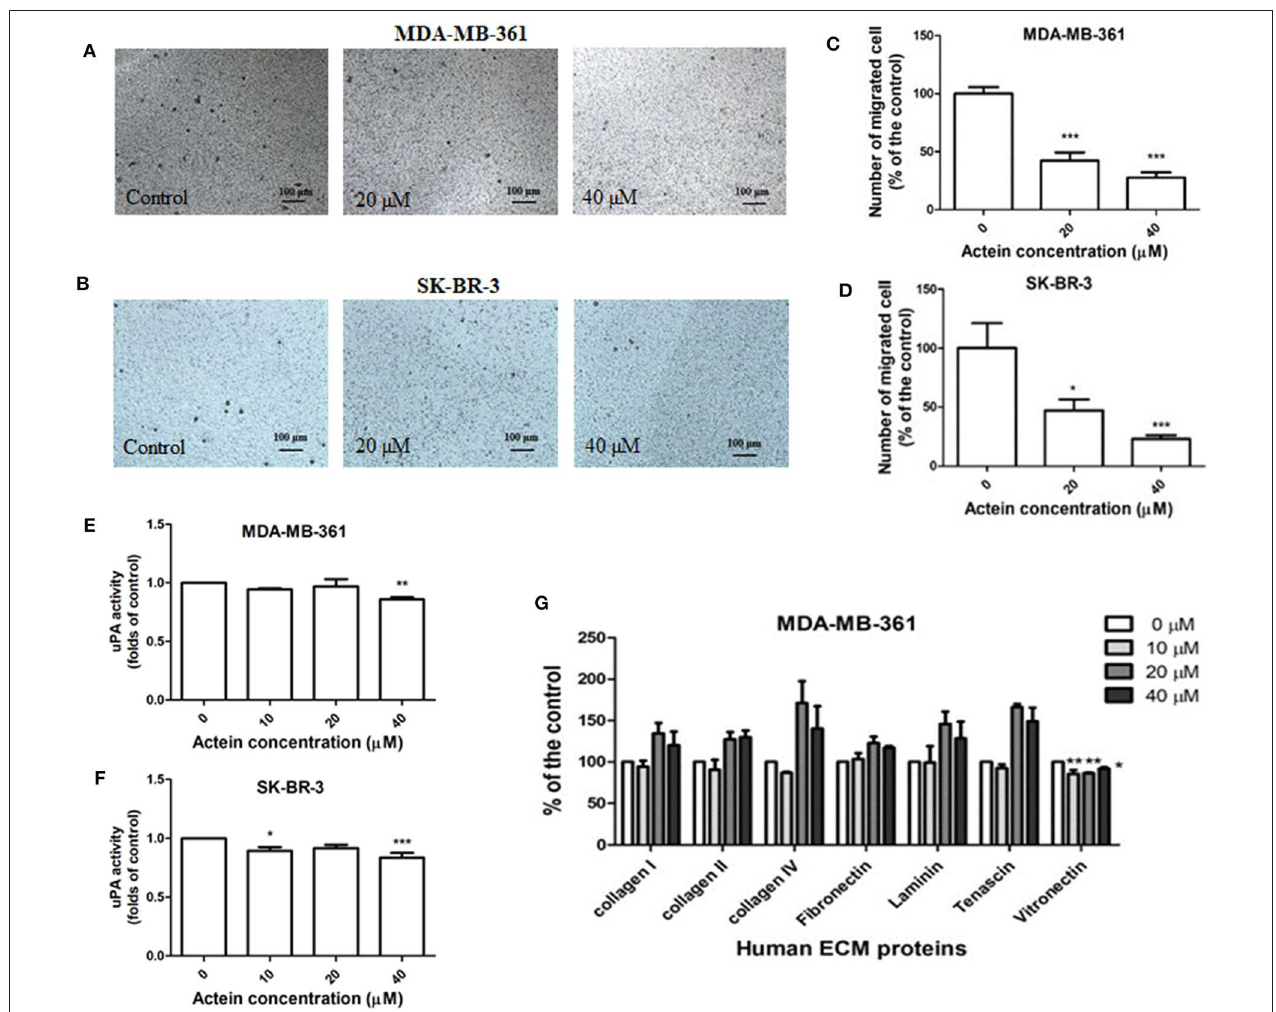
FIGURE 2 | Actein inhibited cell migration in HER2 + breast cancer cells. Cells were treated with actein for 5h in transwell migration assay. Representative photographs show the stained migrated (A) MDA-MB-361 cells or (B) SK-BR-3 cells on the lower side of the membrane after incubation. (C,D) Quantitative analysis summarized the number of migrated cells on the lower chambers (mean + SD of three independent experiments with duplicates each) and expressed as the percentage of the control. (E,F) uPA activity assay. uPA activity was measured using a specific uPA substrate releasing a colored chromophore (mean + SD of eight independent experiments in duplicate). (G) Inhibitory effect on MDA-MB-361 adhesion to ECM proteins by ECM-adhesion assay. Results were expressed as the mean fold of the untreated control (mean + SD of three independent experiments in duplicates). Statistical differences were determined by One-way ANOVA, with * p < 0.05, ** p < 0.01, *** p < 0.001 against untreated